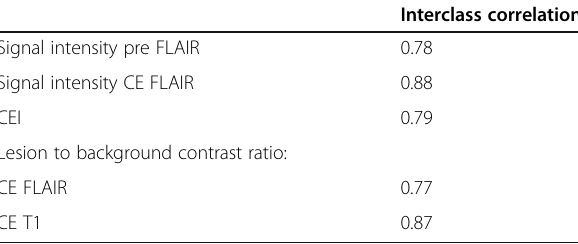
Table 4 Interobserver agreement as regard signal intensity, CEI, and contrast to background